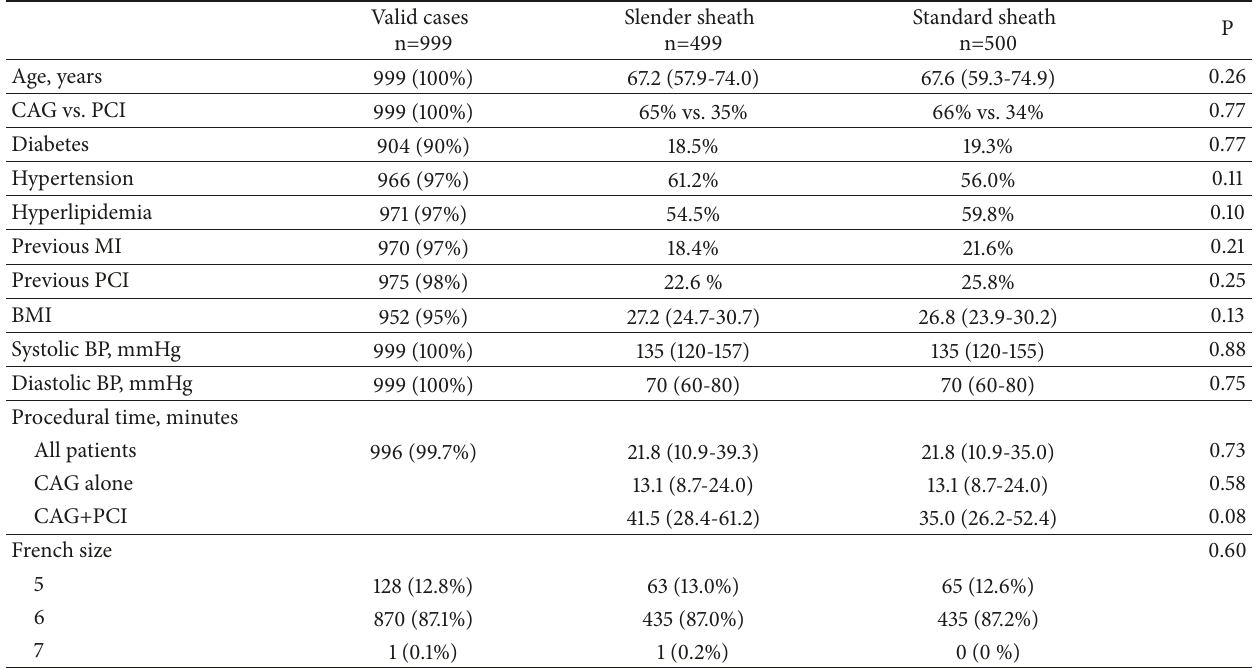
Table 1: Baseline